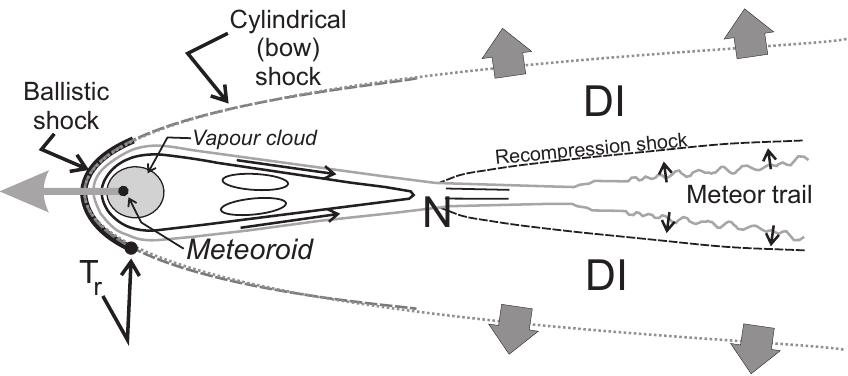
Figure B1. Simplified flow field and shocks expected for transitionally dense and overdense meteors at 80–95km altitude. The flow fields are based on the flows expected for solid bodies entering the atmosphere (see, e.g., Sarma, 2000, Fig. 49), but with accommodation for differences associated with meteoroid characteristics. Not all features are present in all meteor trails – see the text for details. The figure is not to